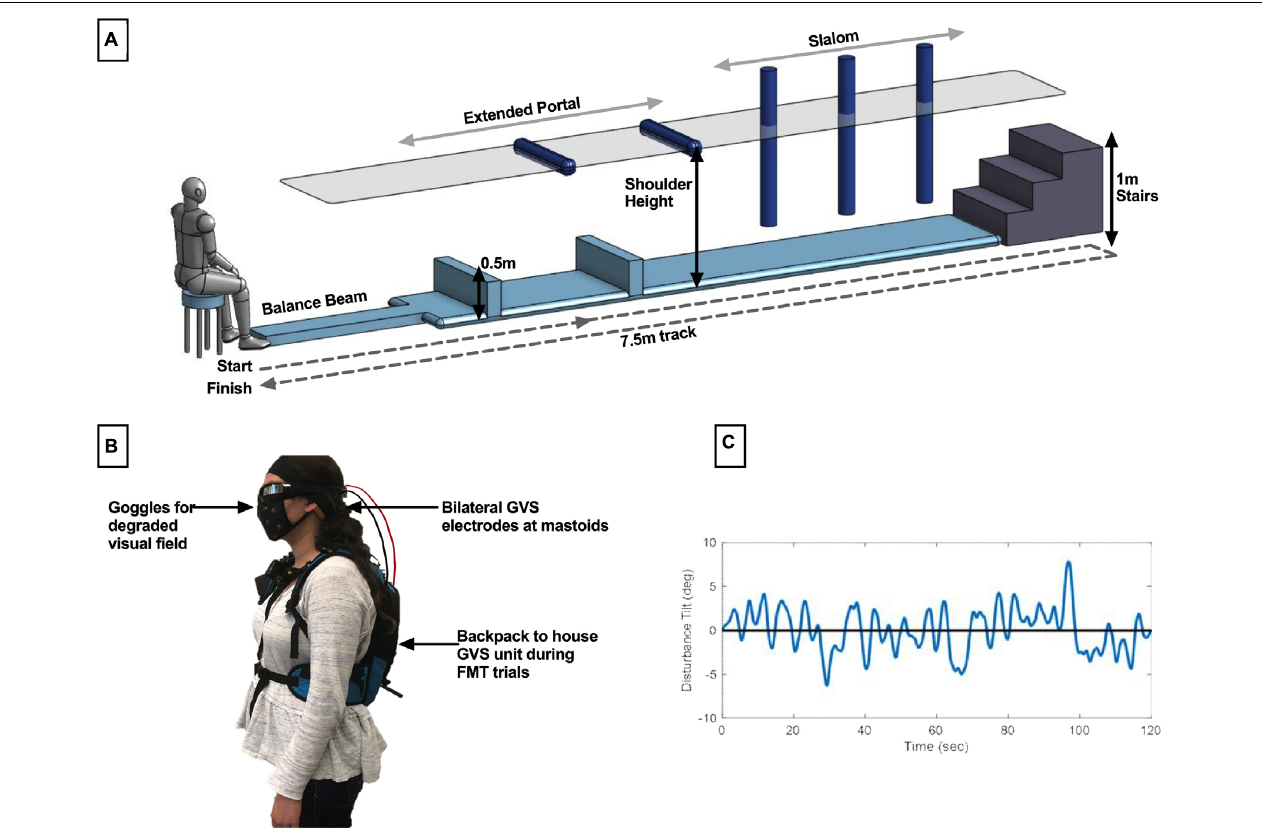
FIGURE 1 | Description of methods. (A) The modified functional mobility task consisted of a series of obstacles placed along the length of an inflated air track. Hurdles to be ducked under were adjusted to shoulder height, and slaloms were adjusted to be shoulder width. (B) Member of the research team demonstrating electrode placement. For all subjects, bilateral GVS electrodes were placed at the mastoids. In the functional mobility task only, subjects wore goggles for the creation of a degraded visual field. To transport the GVS device with the subject through the course, it was placed in a low-profile backpack. (C) Sample computer-generated, pseudo-random, zero-mean sum-of-sines roll tilt motion profile. Subjects assigned to the manual control task were instructed to use a joystick to null this motion, with the goal of keeping their chair